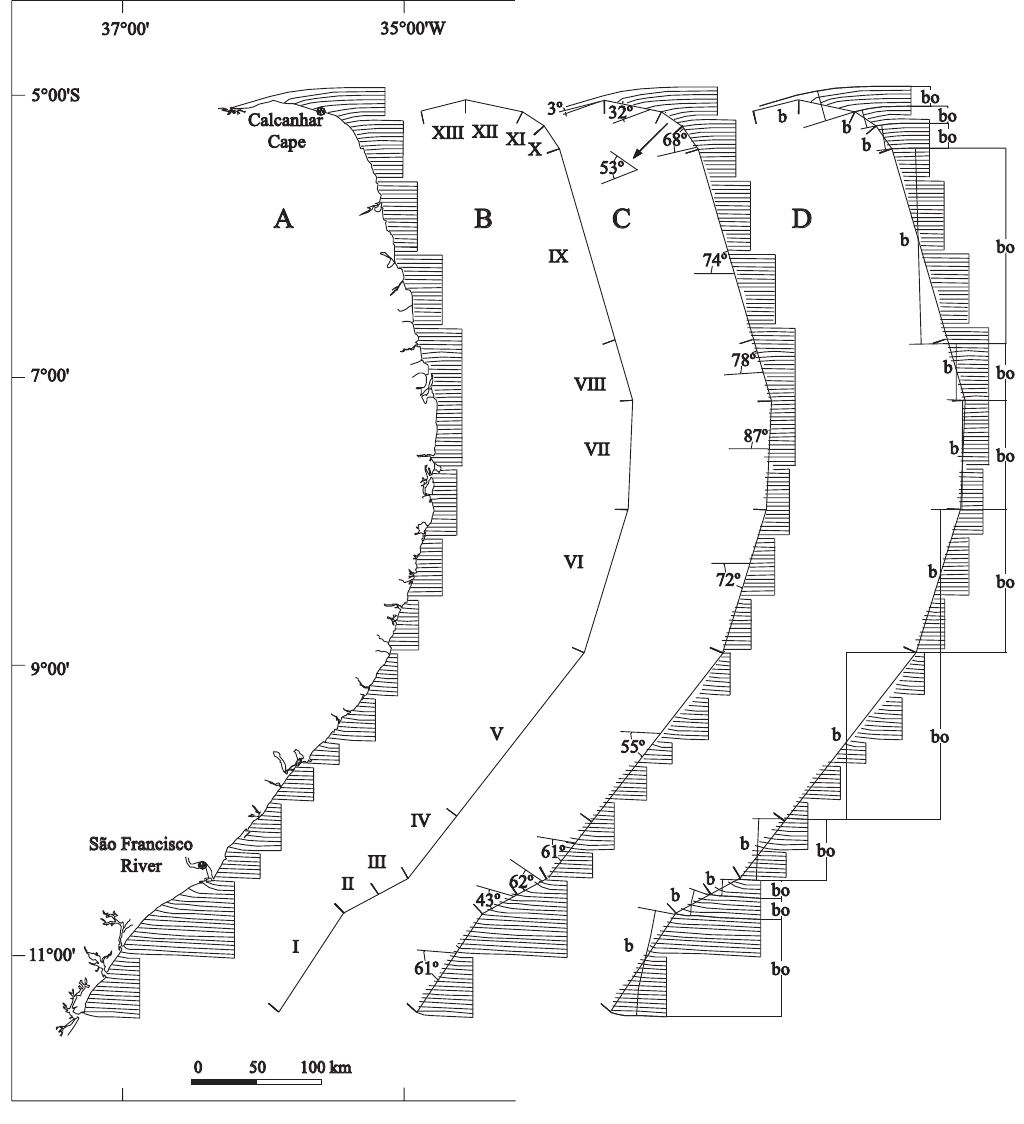
Fig. 3 – A – Refraction diagram for waves with a 5 sec period, arising from the E ( N90 ◦ ) . B – Different segments in which the coastline has been rectilinearized. C – Incidence angles formed by waves from E in relation to the rectilinearized coastal segments. D – Measurements of b and b o for estimating the height of waves along the rectilinearized coastal segments.